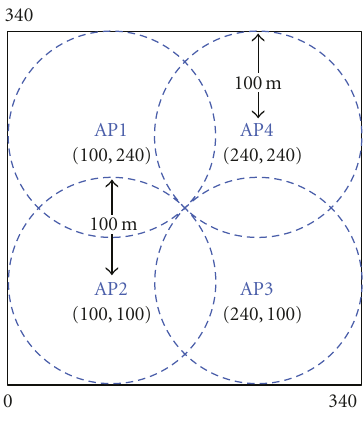
Figure 21: The deployment of overlay